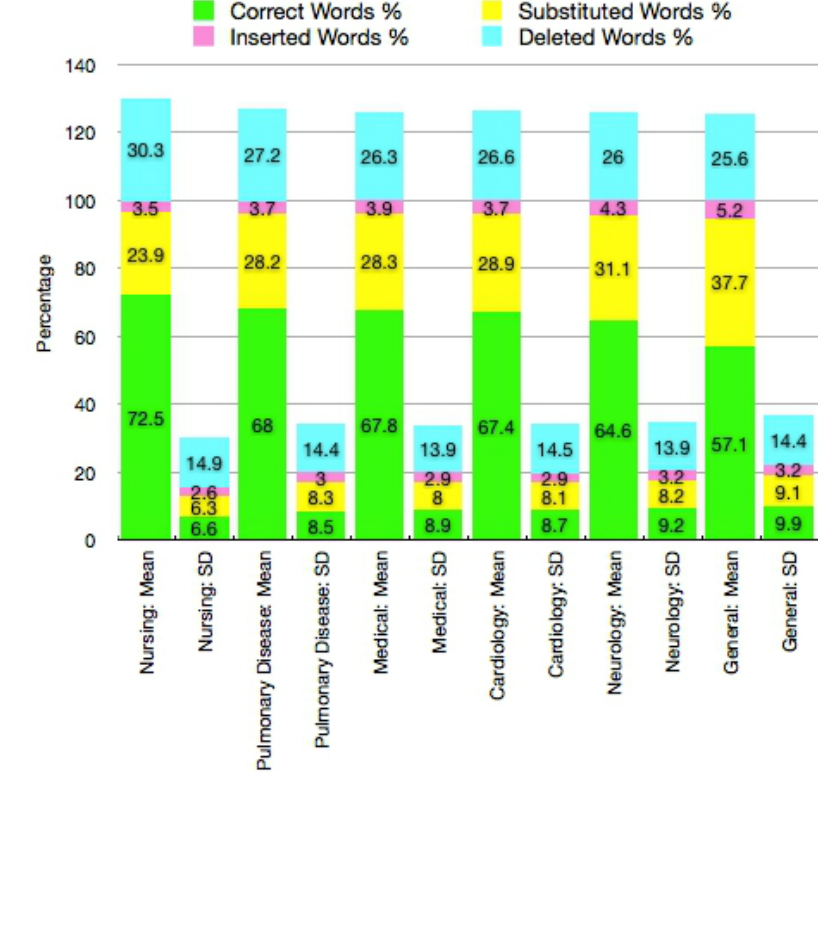
Figure 3. Speech recognition performance with the vocabularies of general, medical, nursing, cardiology, neurology, and pulmonary disease illustrated as a summary over the 100 documents. The notation of the x axis details the mean and SD for each Dragon